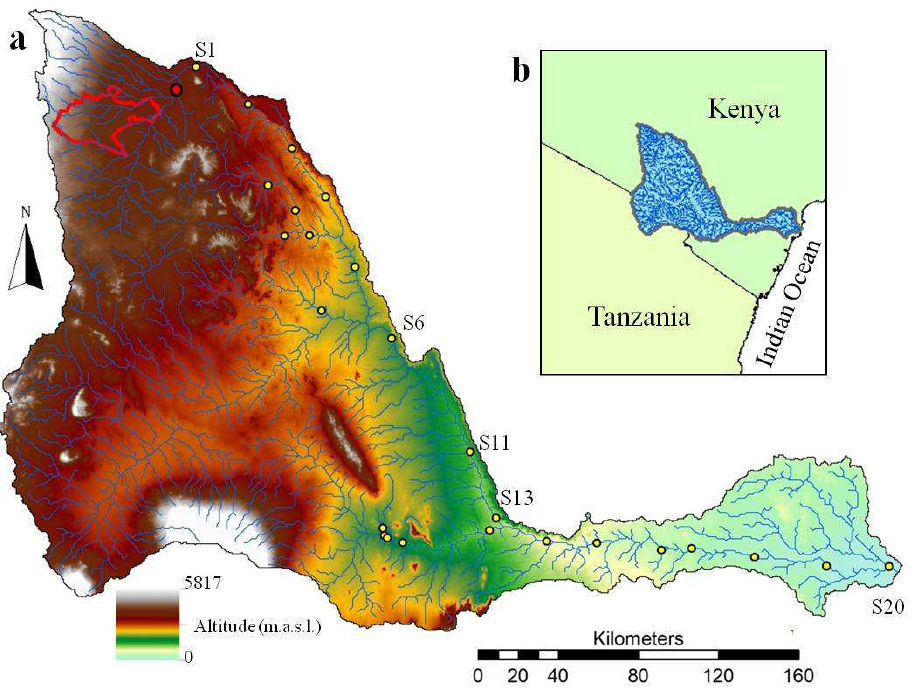
Fig. 1. (a) Digital elevation model (DEM) of Athi–Galana–Sabaki (A-G-S) River catchment (yellow circles = sample sites). The Nairobi River drains the area upstream of and within the Nairobi city administration boundary (red polygon), with the red circle indicating the confluence with the Athi River. Downstream of S13 the Athi River is joined on its right bank by the Tsavo, draining the areas below Mount Kilimanjaro in the south-west of the catchment. Downstream of the Athi–Tsavo confluence, the river takes the name Galana. The river is referred to as the Sabaki River in the vicinity of S20. (b) The inset map shows the position of the A-G-S catchment within south-eastern Kenya and north-eastern Tanzania.